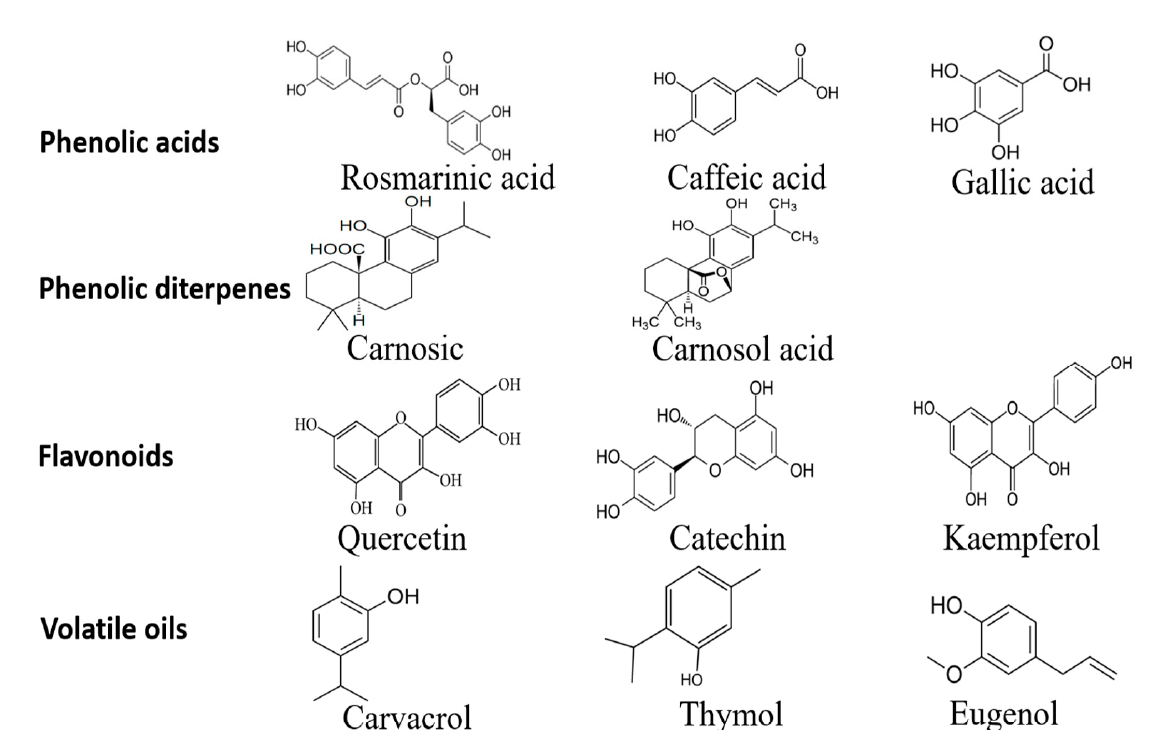
Figure 1. Chemical structures of selected plant-based phenolic